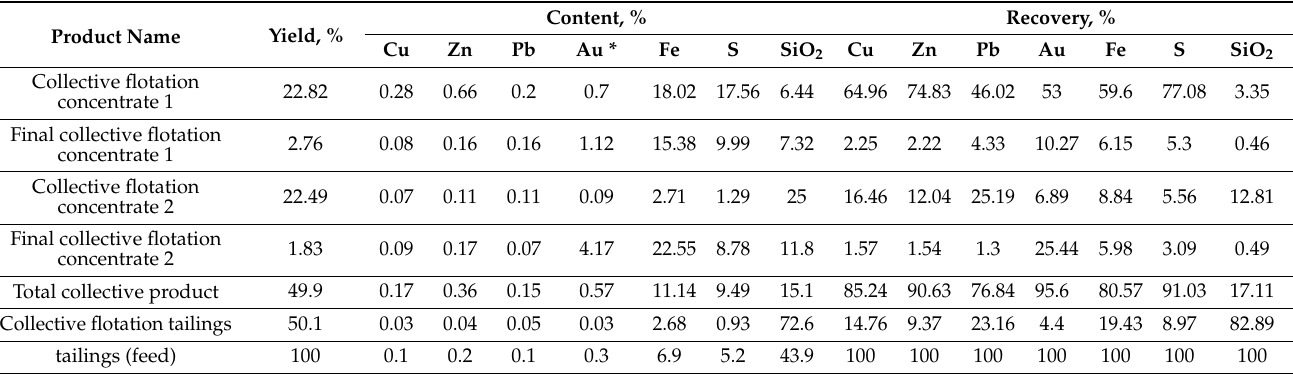
Table 5. The results of two-stage collective flotation of tailings.